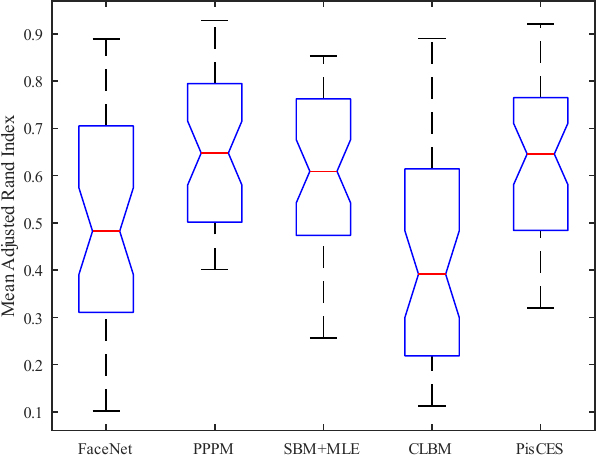
Figure 7. Comparison of the proposed model with 4 different models on MARI (reality network).